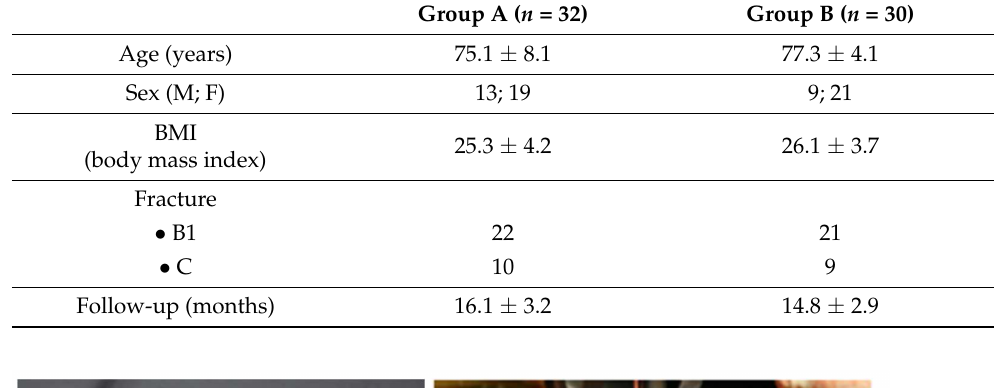
Table 1. Demographic data.